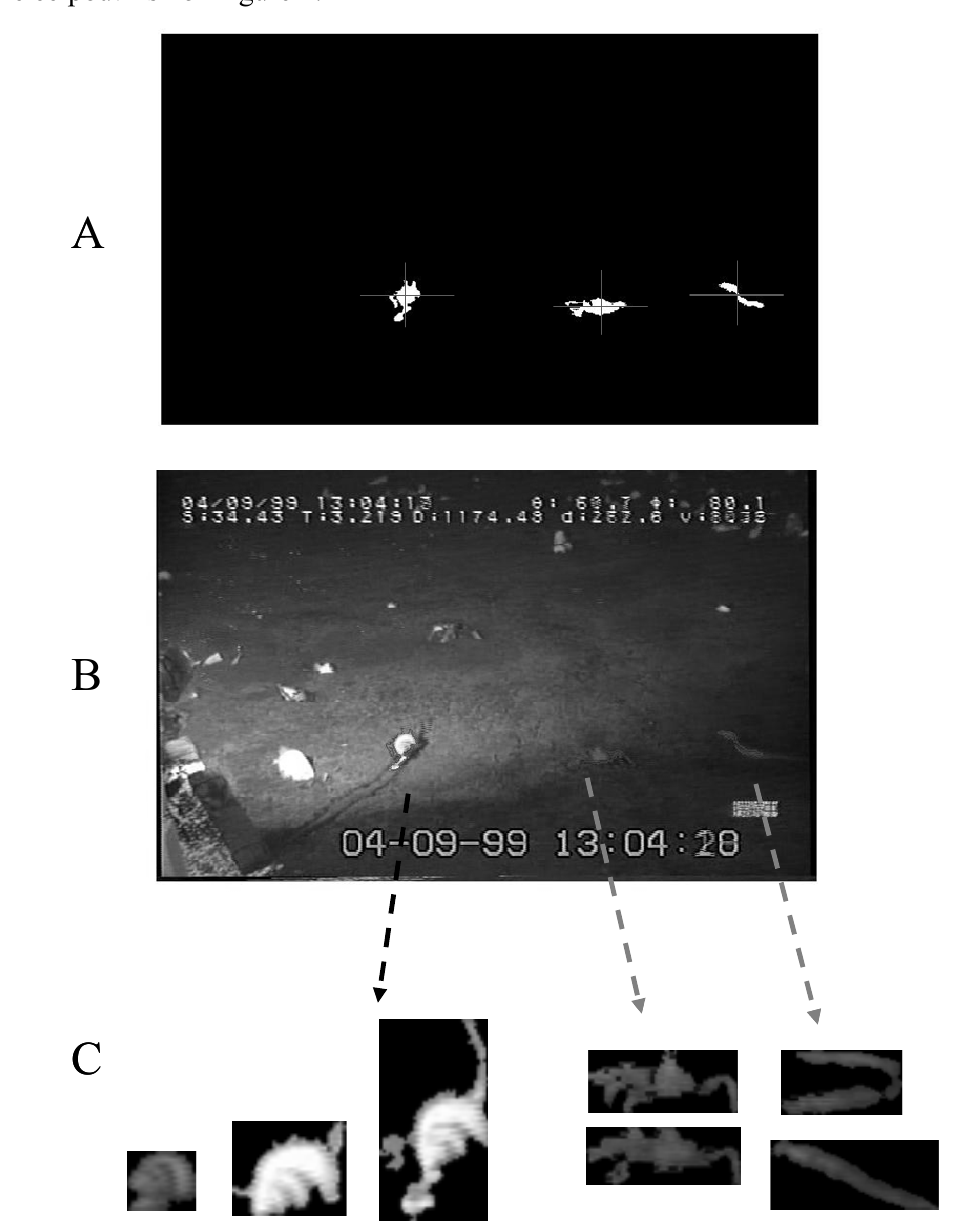
the eelpout fish of Figure